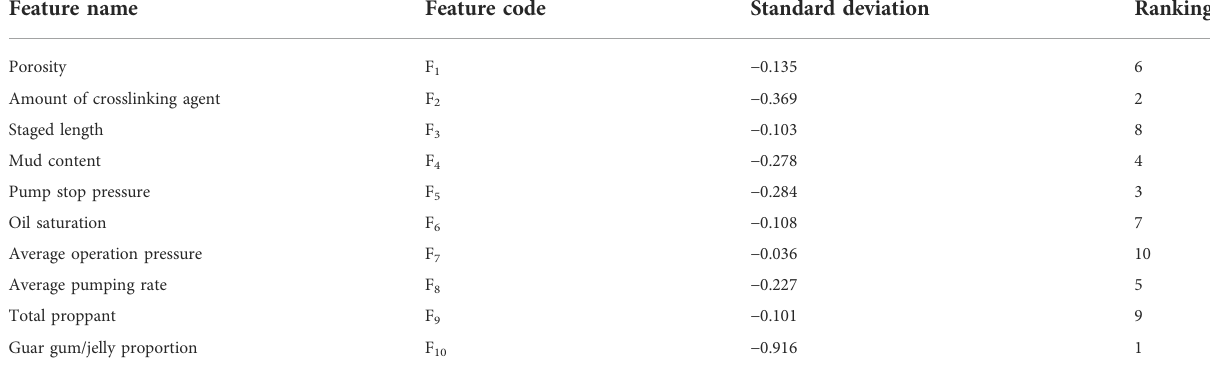
TABLE 5 The ranking of main control